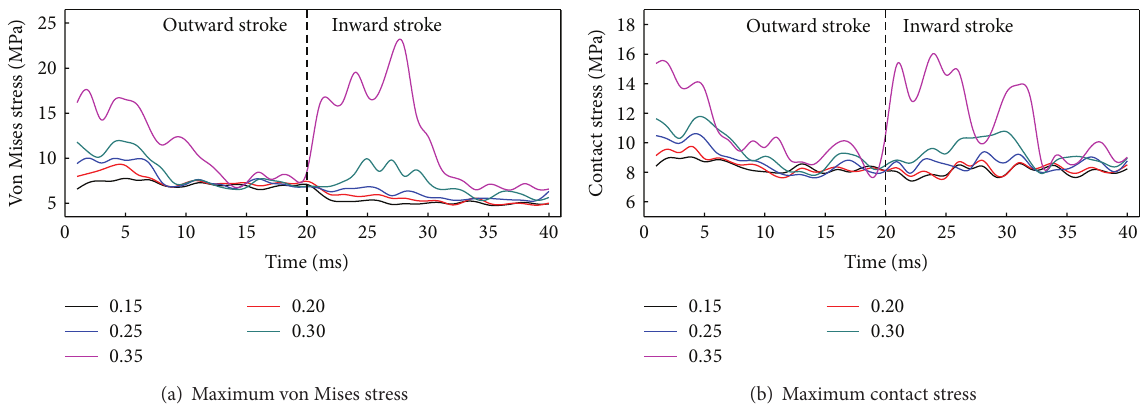
Figure 16: Stress of the biomimetic sealing ring under different friction coefficients.